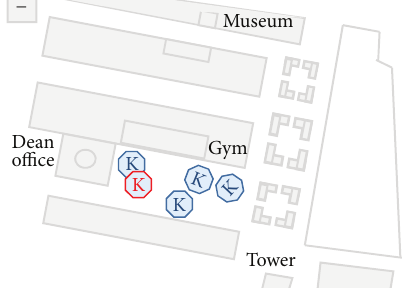
Figure 5: The AR view, watching at a kiosk from the north-east side of the kiosk.